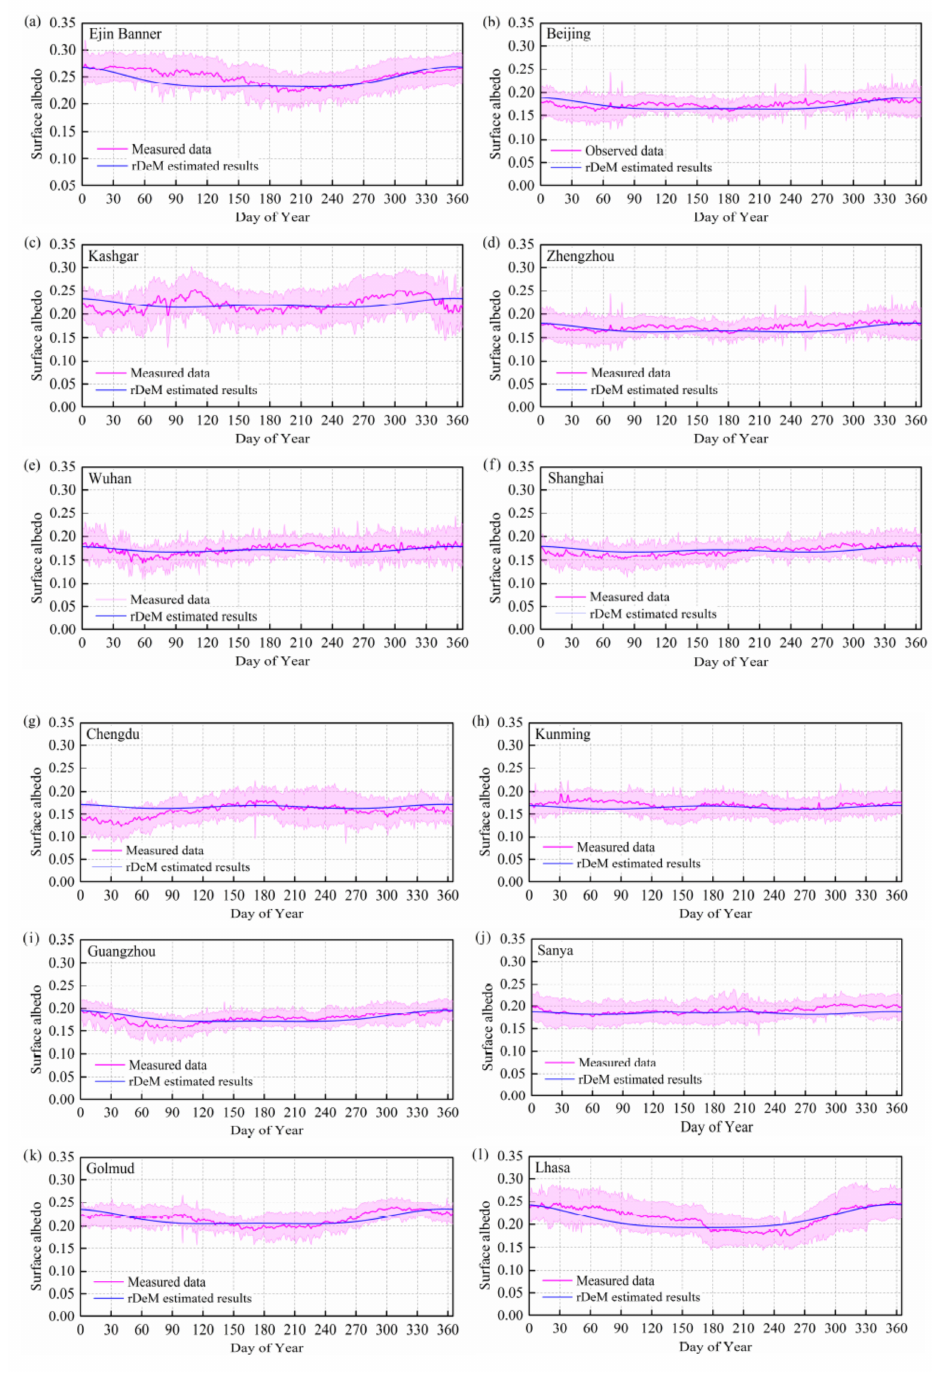
Figure 7. Comparisons of rDeM predictions with measured data at ( a ) Ejin Banner, ( b ) Beijing, ( c ) Kashgar, ( d ) Zhengzhou, ( e ) Wuhan, ( f ) Shanghai, ( g ) Chengdu, ( h ) Kunming, ( i ) Guangzhou, ( j ) Sanya, ( k ) Golmud, and ( l ) Lhasa